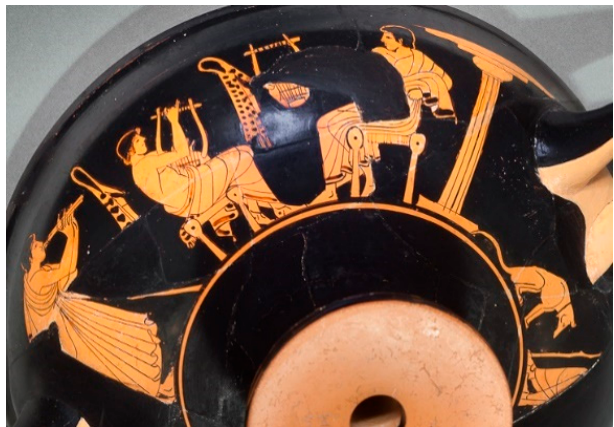
Figure 20. Mead Museum, Amherst College, 1962.74, Dokismasia Painter, 500–450. Used with permission.